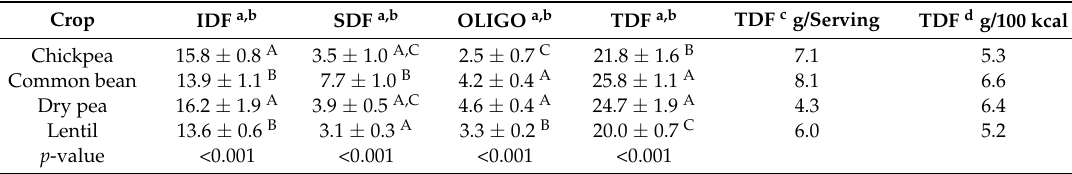
Table 5. Dietary fiber content of pulse